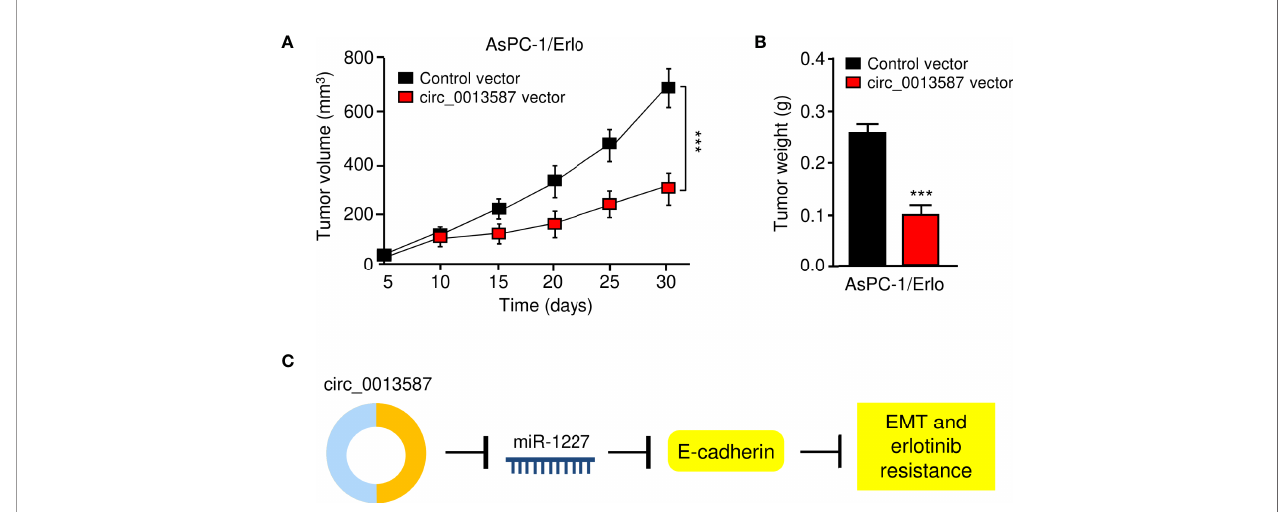
FIGURE 8 | Overexpression of circ_0013587 reverses erlotinib resistance in pancreatic cancer in vivo . (A) Mice were injected with AsPC-1/Erlo cells stably expressing circ_0013587 or AsPC-1/Erlo control cells and were treated with erlotinib. Tumor growth was measured every 5 days to draw the growth curve. (B) Tumor weight was recorded for each derived xenograft tumor. (C) A schematic model showing that circ_0013587 reverses erlotinib resistance in pancreatic cancer cells by regulating the miR-1227/E-cadherin pathway. *** P